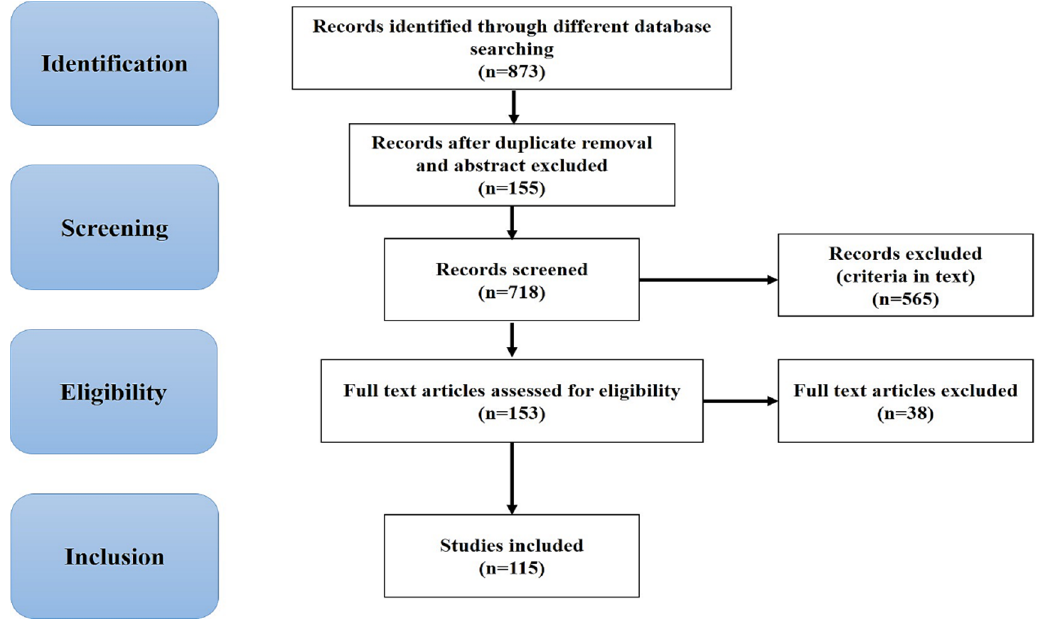
Figure 2. Flow diagram showing the search strategy, the number of records identified, and the included/excluded studies [16].